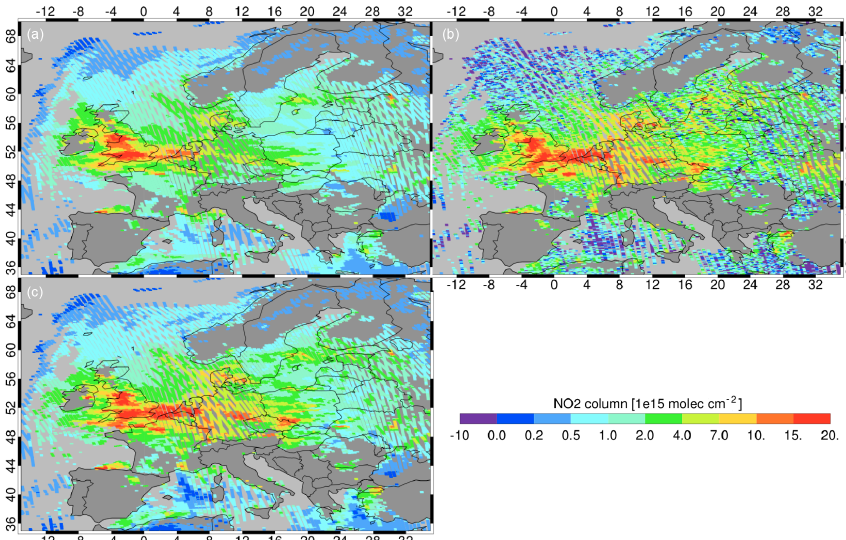
Figure 3. Example result of the assimilation of OMI NO 2 tropospheric column amounts (DOMINO-2 product, b ) on 26 March 2007 in the LOTOS-EUROS regional air quality model (model simulation for OMI ground pixels is provided in a by spatial interpolation and by applying the averaging kernels). LOTOS-EUROS makes use of the ensemble Kalman filter to optimize model processes by assimilating observations. In this case, the surface NO x emissions are adjusted to optimize the match with the tropospheric NO 2 columns observed. The resulting analysis is shown in (c) . OMI observations for cloud-covered scenes (cloud radiance fraction >50%) are